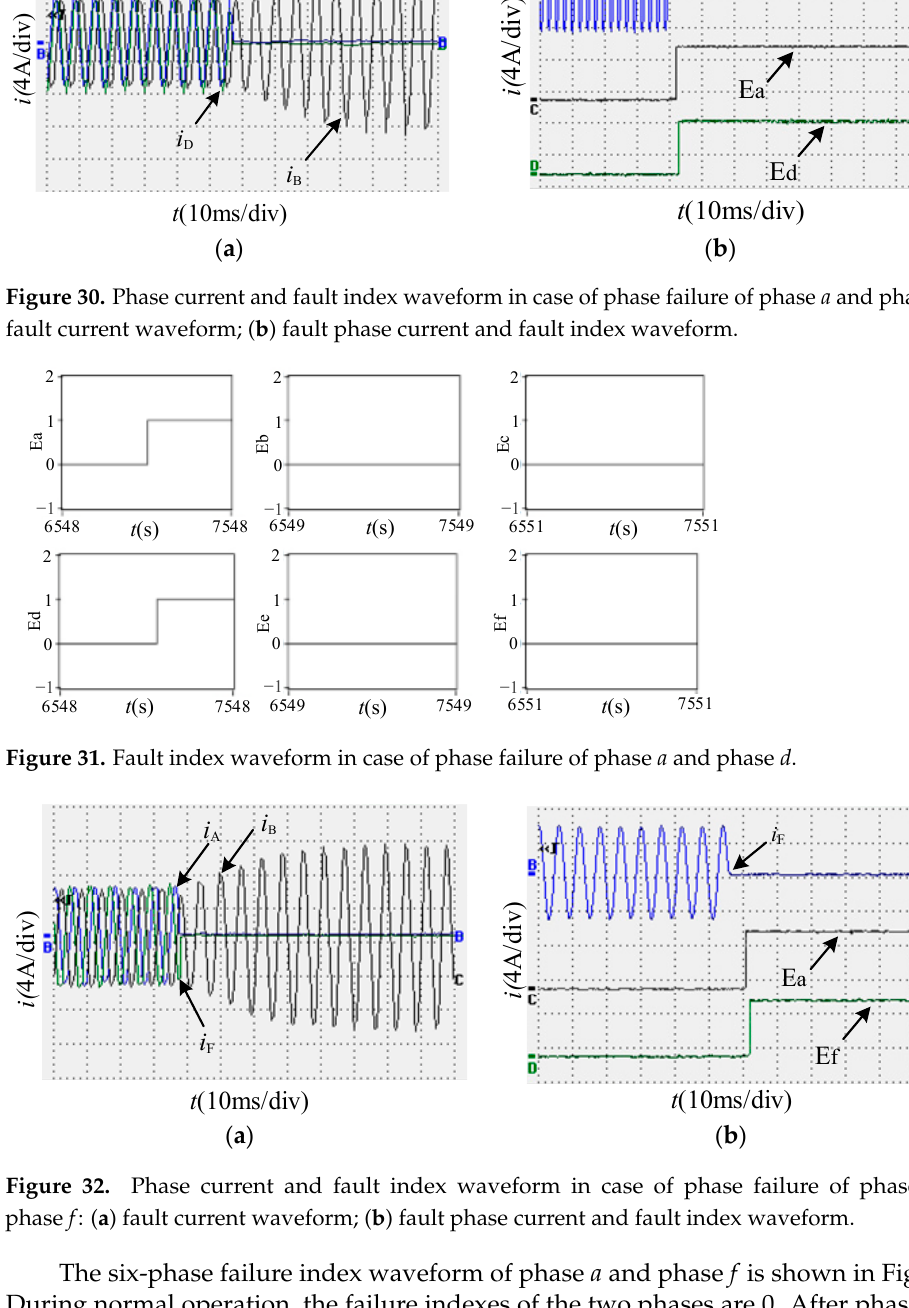
The six-phase failure index waveform of phase a and phase f is shown in Figure